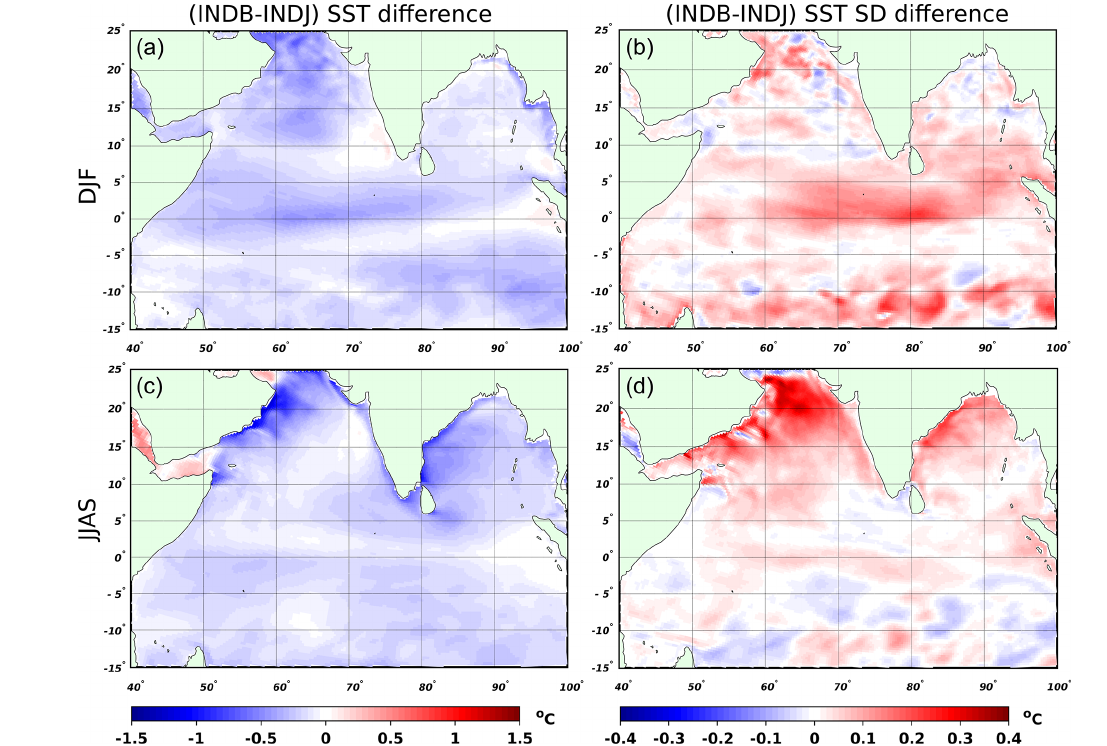
Figure 9. Spatial distribution of the difference between model runs (INDB–INDJ) for SST ( a , c ) and SST standard deviation (SD, b , d ). SST and its standard deviation are time-averaged seasonally (DJF, JJAS) for the period